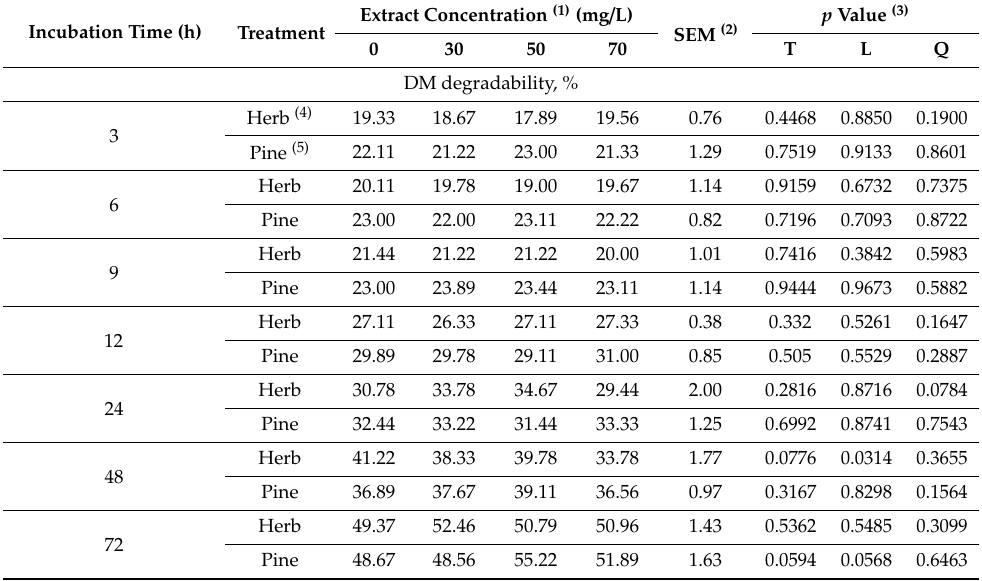
Table 3. E ff ects of terpene-based plant extracts on dry matter (DM) degradability after 72 h of in vitro incubation.